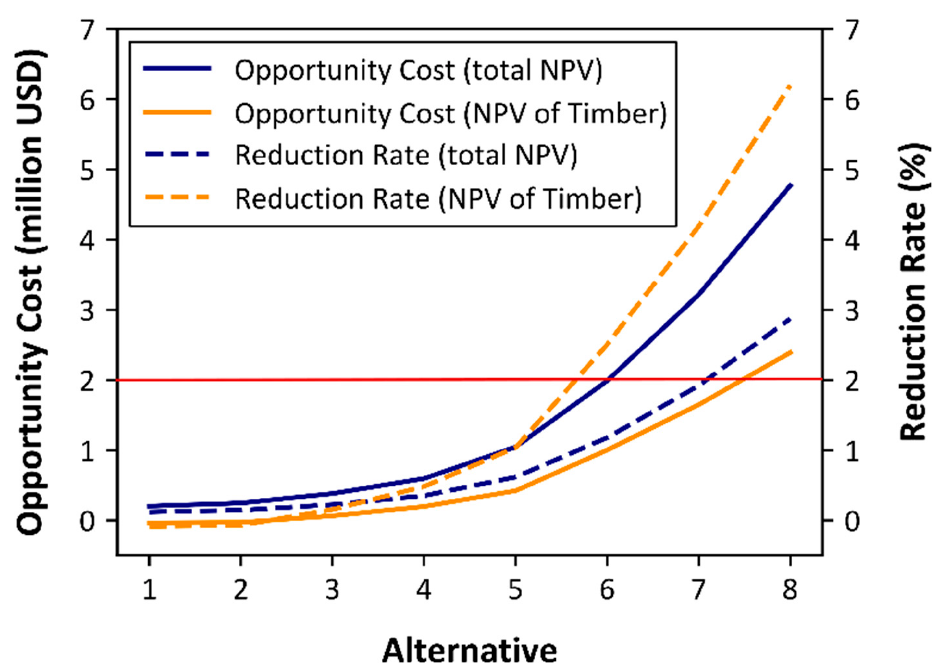
Figure 11. Opportunity cost and reduction rate on the NPV values analyzed by